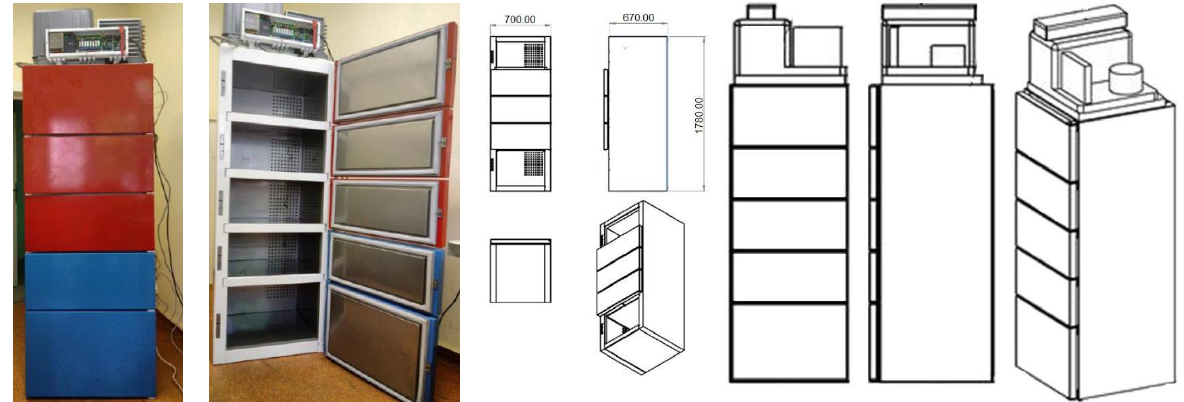
Figure 1. MainBox device with cooling systems cooperating with automation and control (picture, scheme with dimensions in mm) .